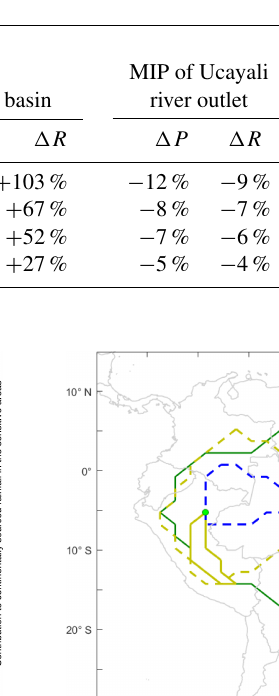
Table 3. Estimated changes in annual rainfall ( (cid:49)P ) and runoff ( (cid:49)R ) over the Ucayali River basin outlet following land use scenarios in different spatial domains.